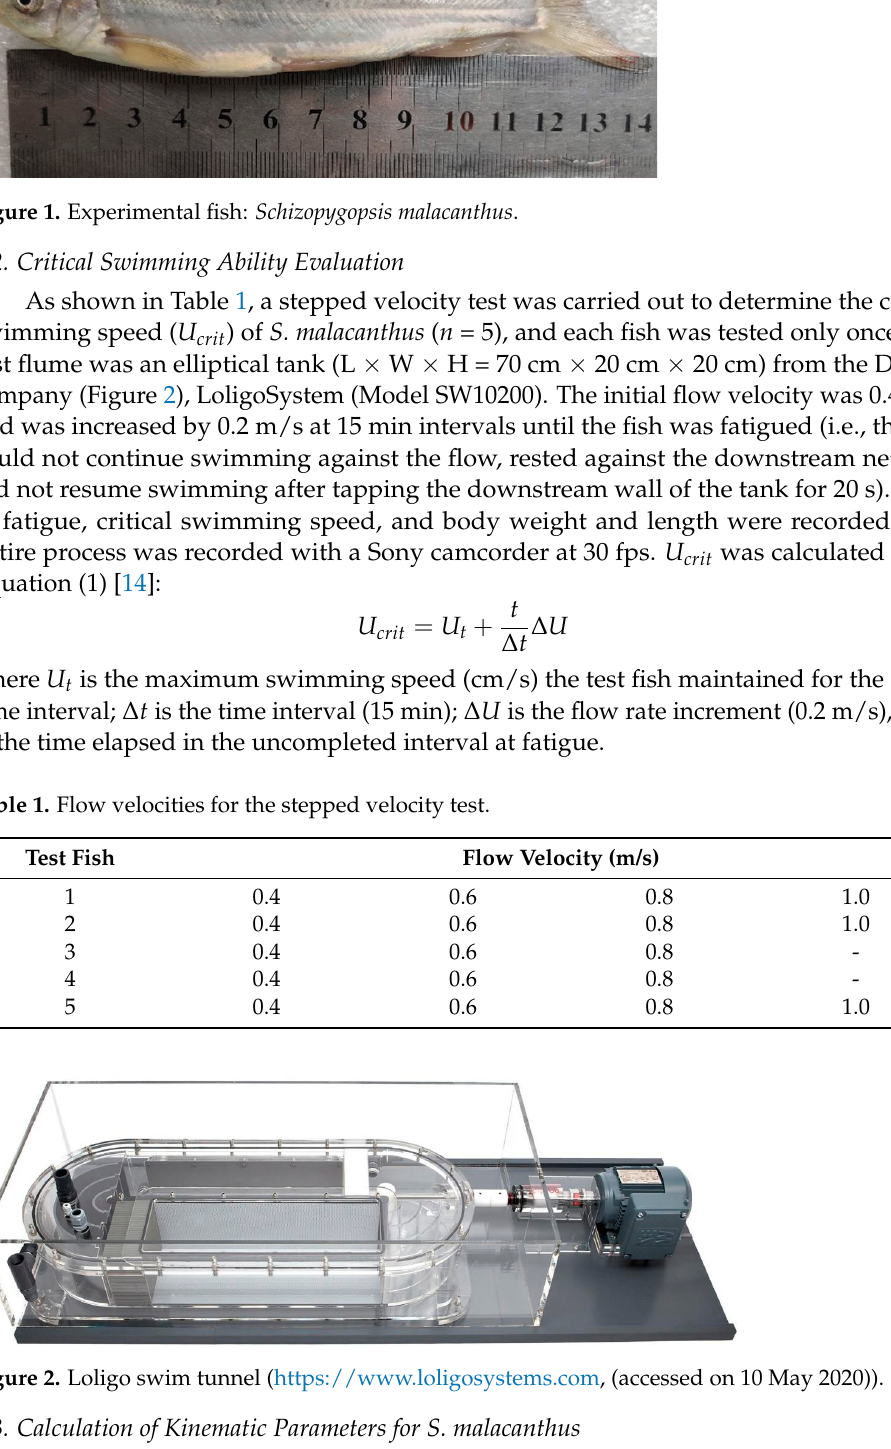
Figure 1. Experimental fish: Schizopygopsis malacanthus .